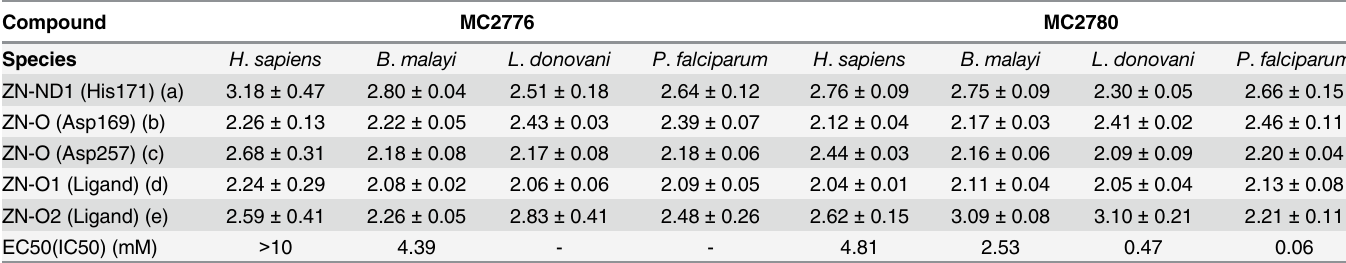
Table 2. Distances of the catalytic zinc atom to the binding residue and ligand chelating atoms in the models of MC2776 and MC2780 docked to KDAC1 protein of different species. The distances shown are in the unit of Angstroms. The chemical formulae for both ligands are depicted in Fig 1. O1 and O2 are from hydroxamate group of the ligands. Other atoms are from the protein, as shown in Figs 4 and 5. The coordinates of the models as pdb file are available in S1 Supporting Materials. Compound MC2776